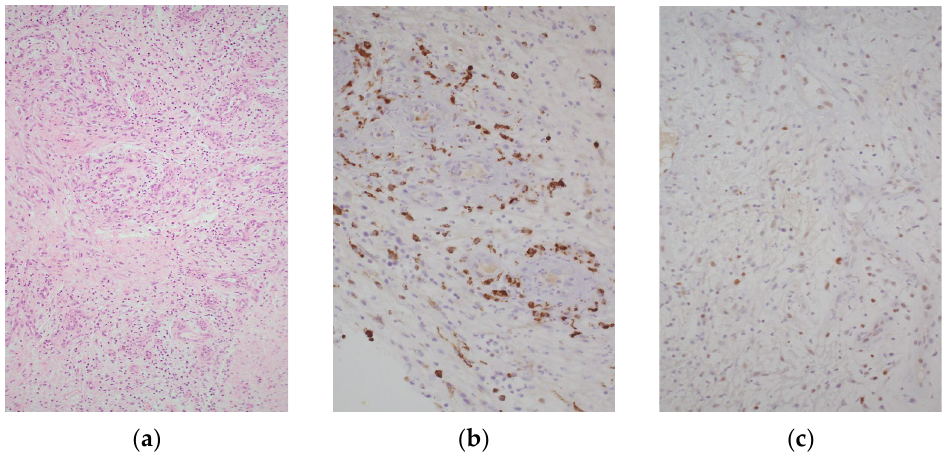
Figure 3. Bioptic human tissue after treatment with PBMNCs: ( a ) hematoxylin and eosin—granulation tissue permeated by chronic inflammation with a rich granulocyte and macrophage population; ( b ) immunohistochemistry (IHC)—CD68 is a pan macrophage marker (M0 + M1 + M2); ( c ) IHC—C-Myc marks the M2 subpopulation in